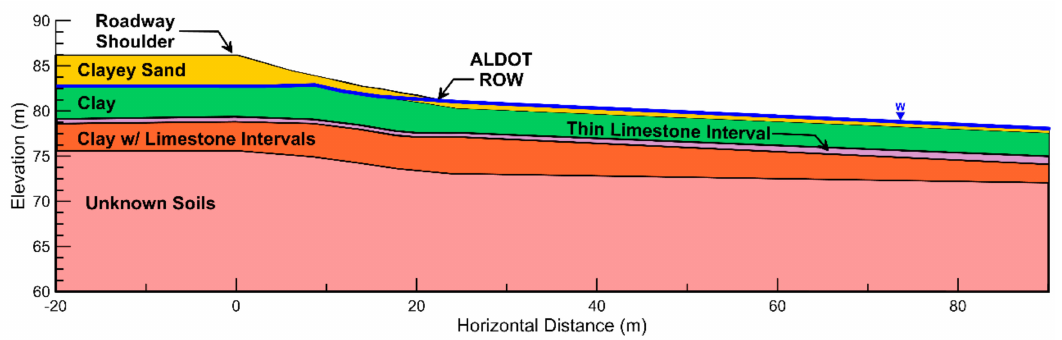
Figure 2. Simplified site model to be used in slope stability analyses as estimated from integrated site characterization for analysis